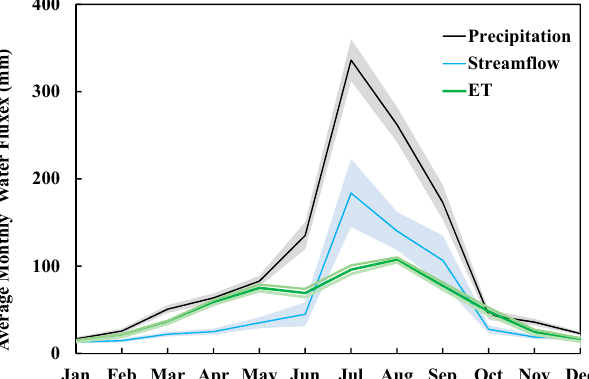
Figure 10. Monthly averages of precipitation (P), streamflow (Q), and evapotranspiration (ET) over the simulation period. Shaded areas are the standard errors of the respective time series.